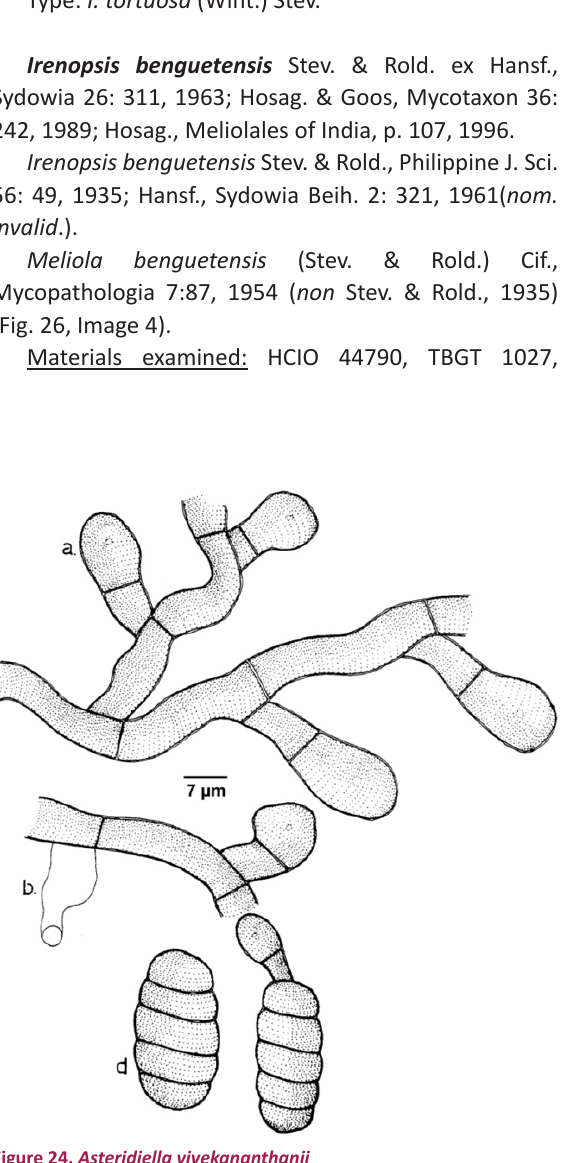
Figure 24. Asteridiella vivekananthanii a - Appressorium; b - Phialide; d - Ascospores